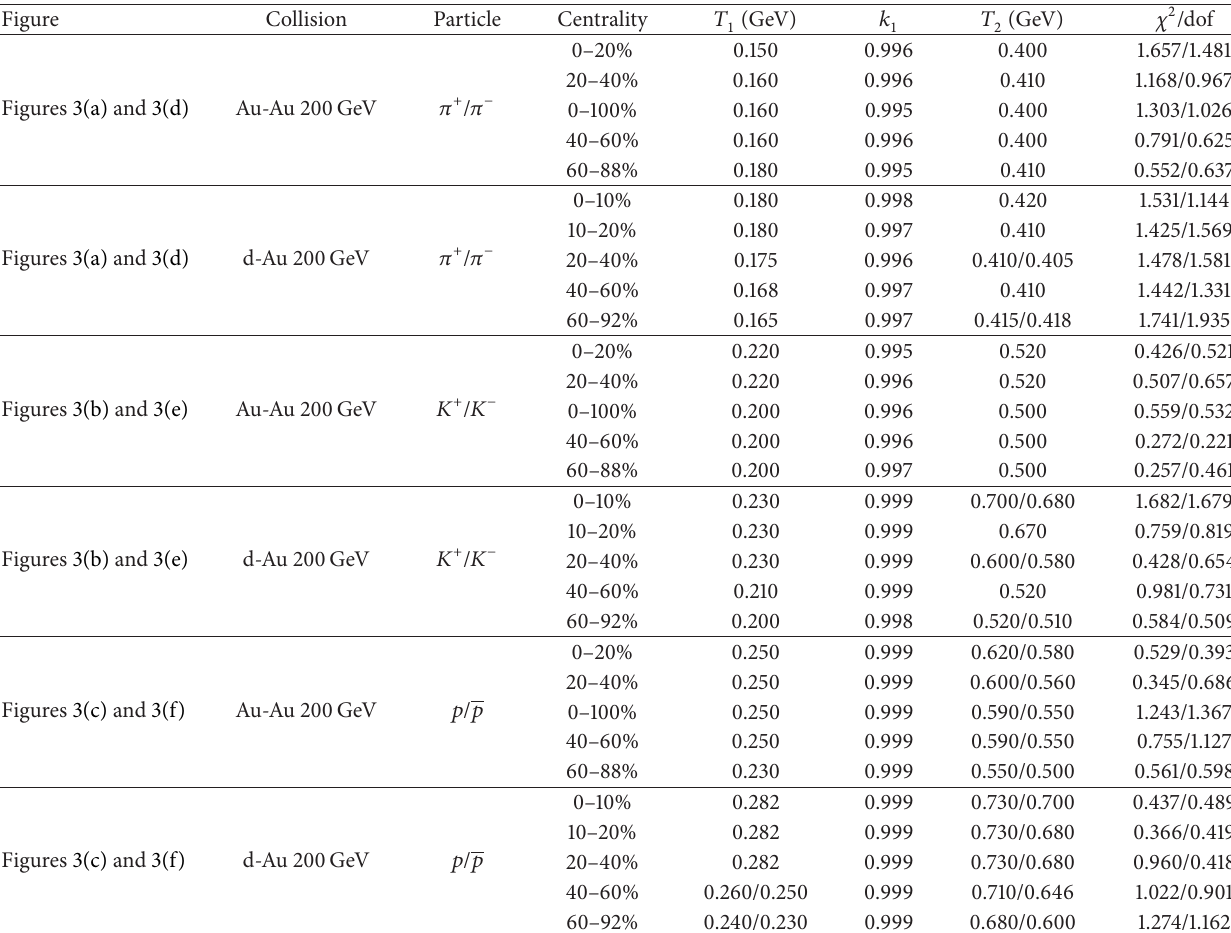
Table 2: Parameter values corresponding to the curves in Figure 3 for Au-Au and d-Au collisions at √𝑠 𝑁𝑁 = 200 GeV. The values for positively/negatively charged particles are given in terms of “the first value/the second value” in the case of the two values being different. The relative errors estimated for 𝑇 1,2 and 𝑘 1 are less than 6% and 0.5%,